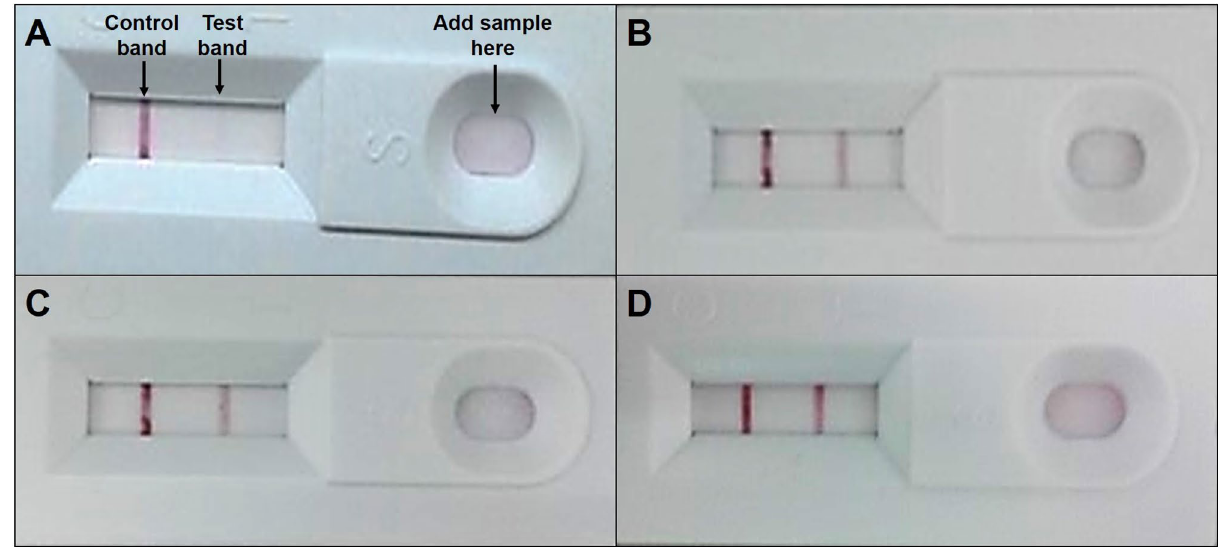
Figure 2. Lenti-X™ GoStix™ viral titration. Two bands on the stick indicate the presence of virus at greater than 5 × 10 5 IFU/mL. ( A ) Negative control, ( B ) Lentiviral vector 2A, ( C ) Lentiviral vector 3A, and ( D ) Lentiviral vector 3B.